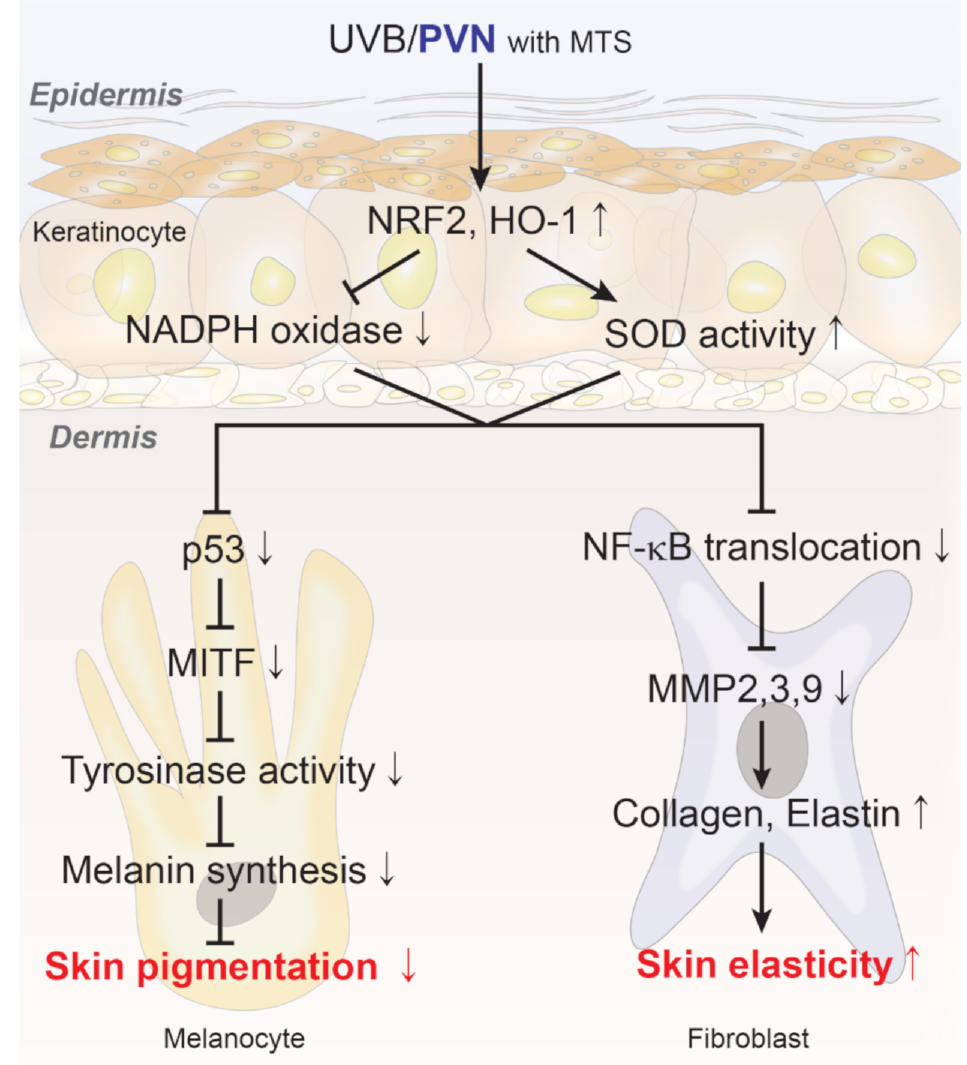
Figure 5. Schematic summary of the effect of PVN on UV-B. HO-1, heme oxygenase-1; HQ,